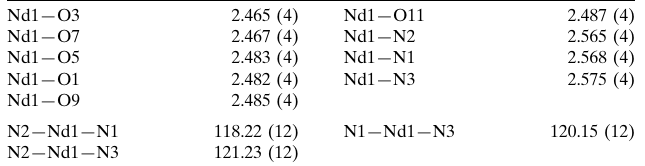
Data collection